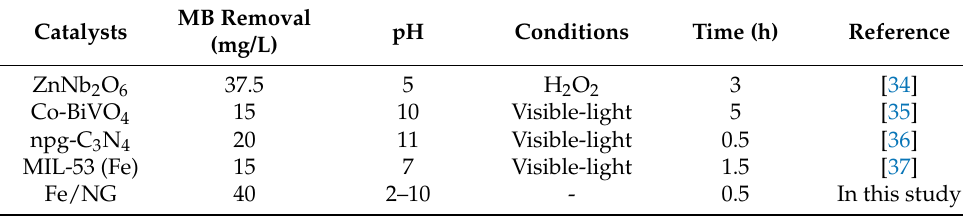
Table 2. Comparison of various modified materials for MB removal.